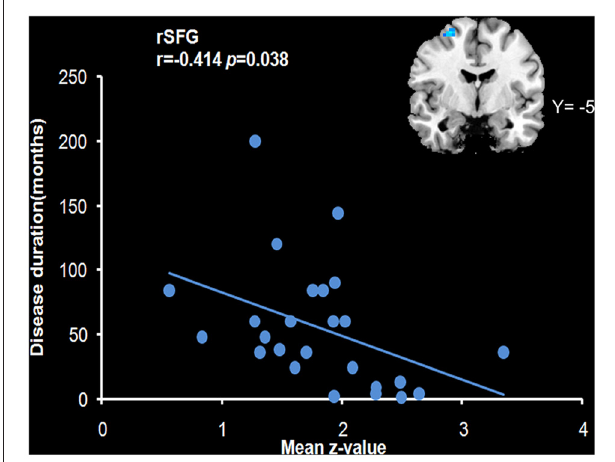
FIGURE 4 | Correlation with the mean z -value of the right superior frontal gyrus (rSFG). The results revealed a negative correlation of the